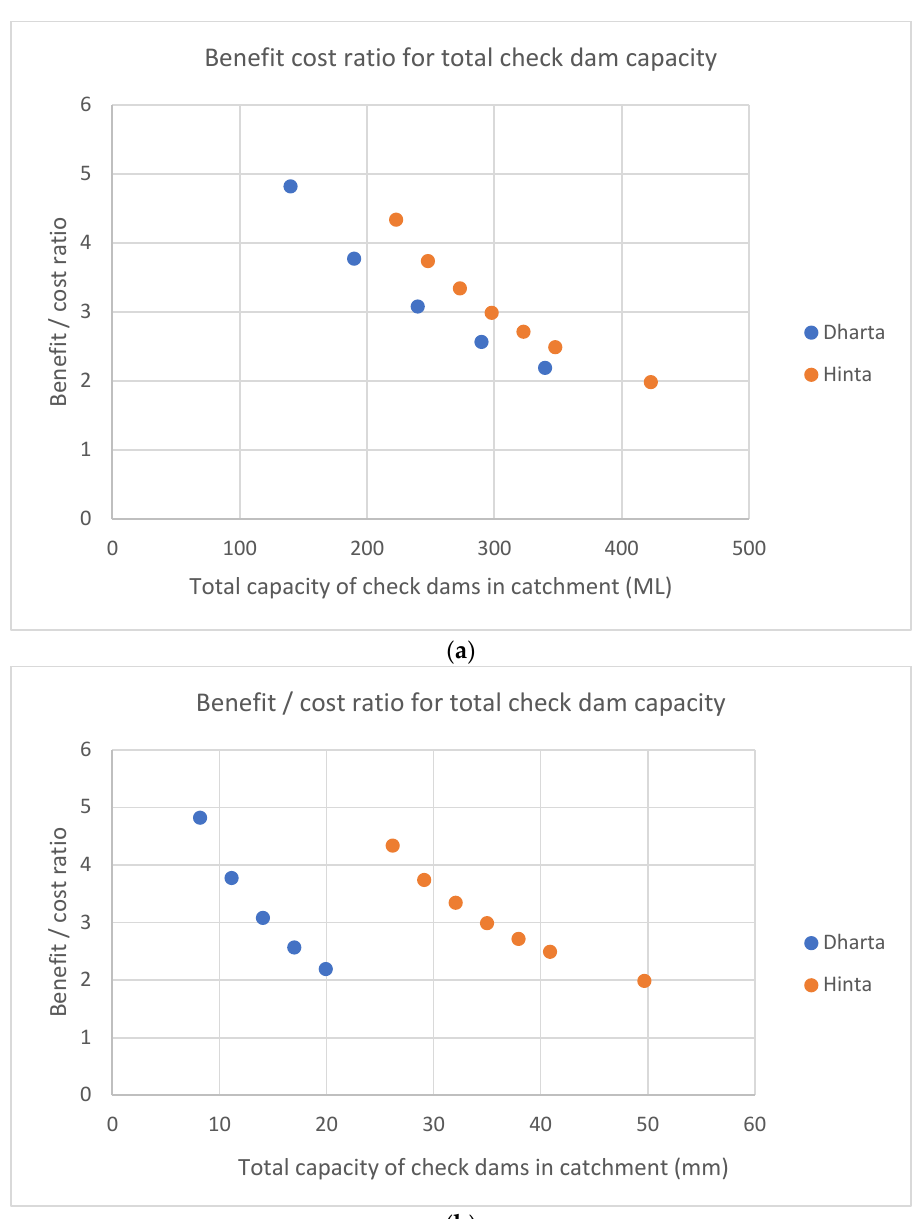
Figure 9. Expected benefit – cost ratio of consortia of check dams in Dharta and Hinta catchments for a range of aggregate capacity, expressed as ( a ) megalitres and ( b ) millimetres over the whole catchment area.